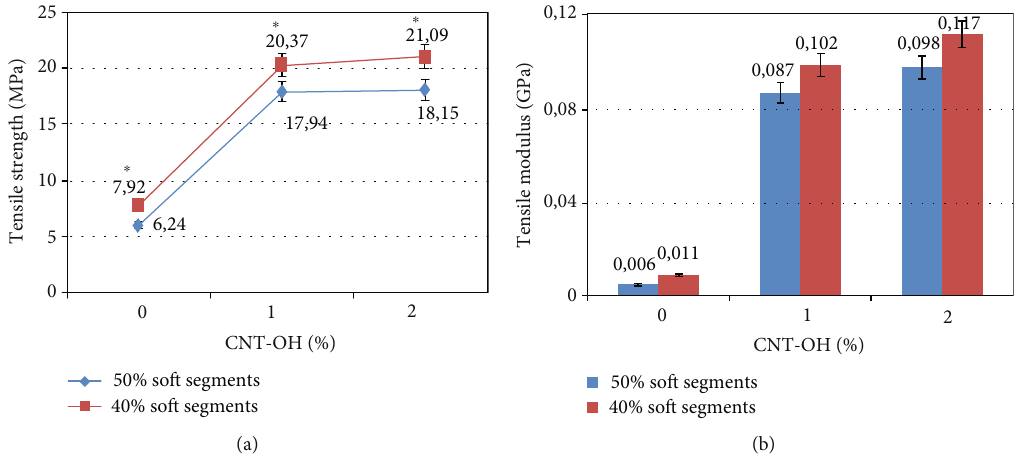
Figure 4: Tensile strength (a) and tensile modulus (b) of neat PU and modi fi ed with CF in function of CNT-OH content ∗ denotes statistically signi fi cant di ff erence between the samples di ff ering in the content of soft segments ( p < 0 : 05